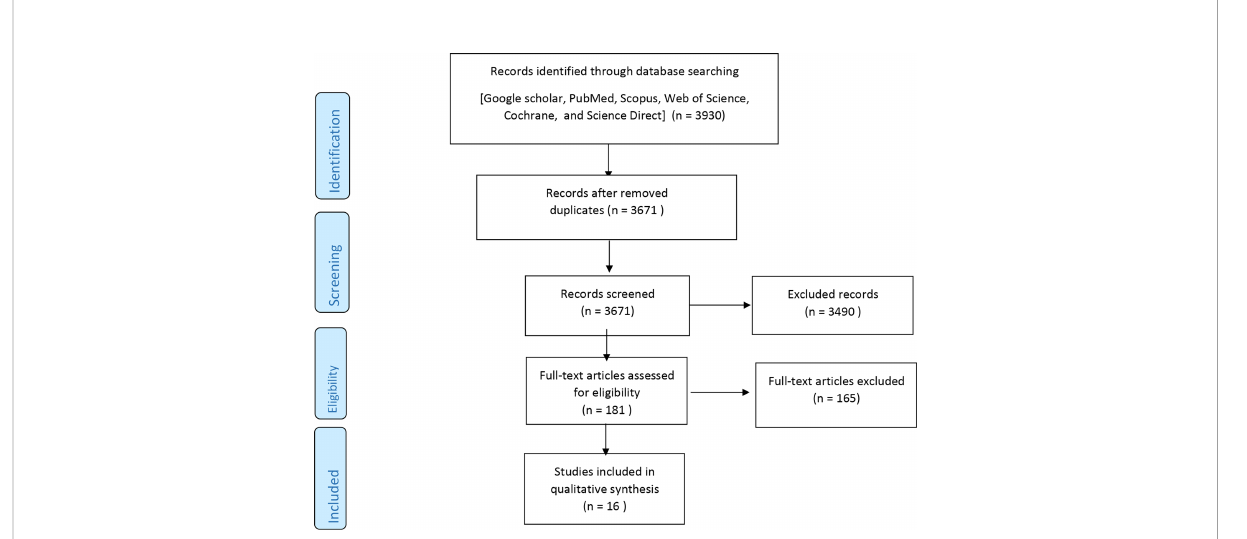
Figure 1. Search method and study